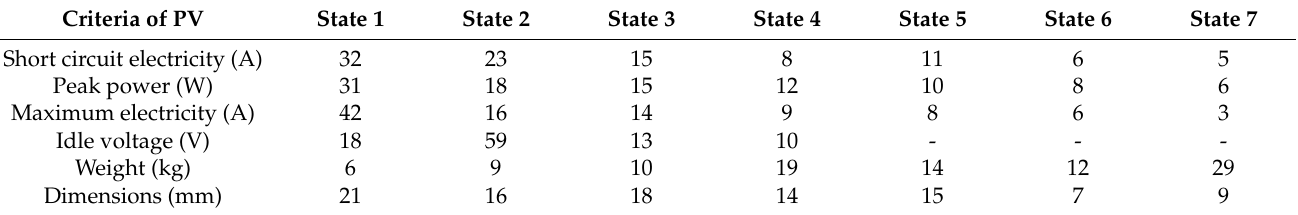
Table 3. Values of the arithmetic means determining the quality of the PV criteria states.